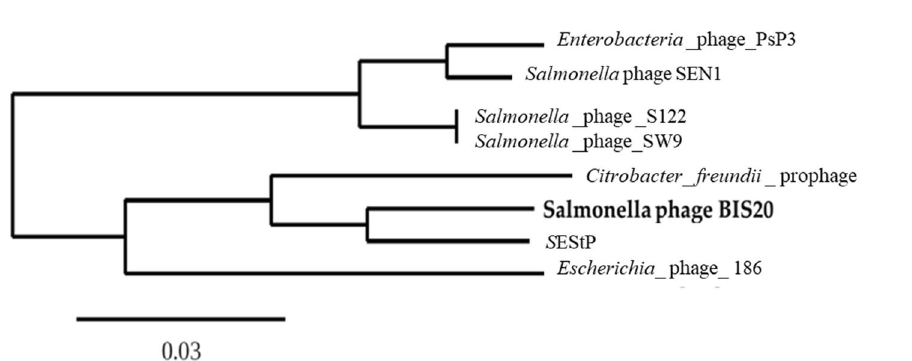
Figure 7. GARD analysis of the amino acid sequence of tail fiber gene with close homologs of BIS20. ( A ) Analysis identifies 8 breakpoints out of which the breakpoint at 300 position is the most probable breakpoint (represented with red dot). ( B ) Software generated phylogenetic tree made at coordinate range of 186–292 places BIS20 as a separate lineage.